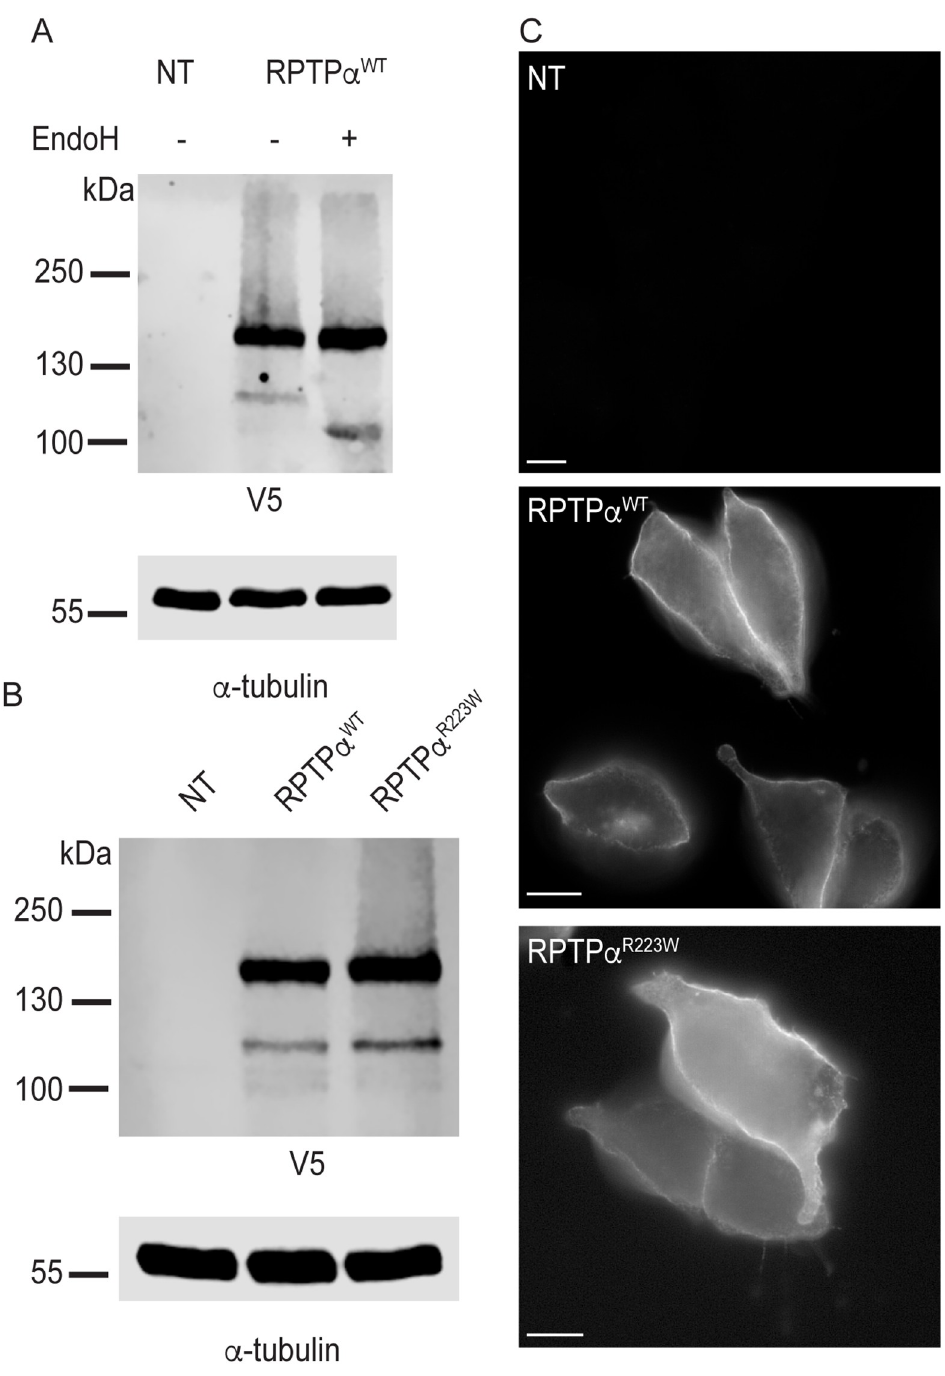
Fig 2. (A) Immunoblot of non-transfected (NT) and RPTP α wild-type (RPTP α WT ) HEK293T cells. The lysates were treated in the presence (+) or absence (-) of endoglycosidase H (EndoH) detected with anti-V5 antibody. (B) Immunoblot of RPTP α WT and RPTP α R223W transfected HEK293T cells detected with anti-V5 antibody. (C) Immunofluorescent image of transfected HEK293T cells stained with anti-FLAG antibody. Scale bar = 10 μ m.